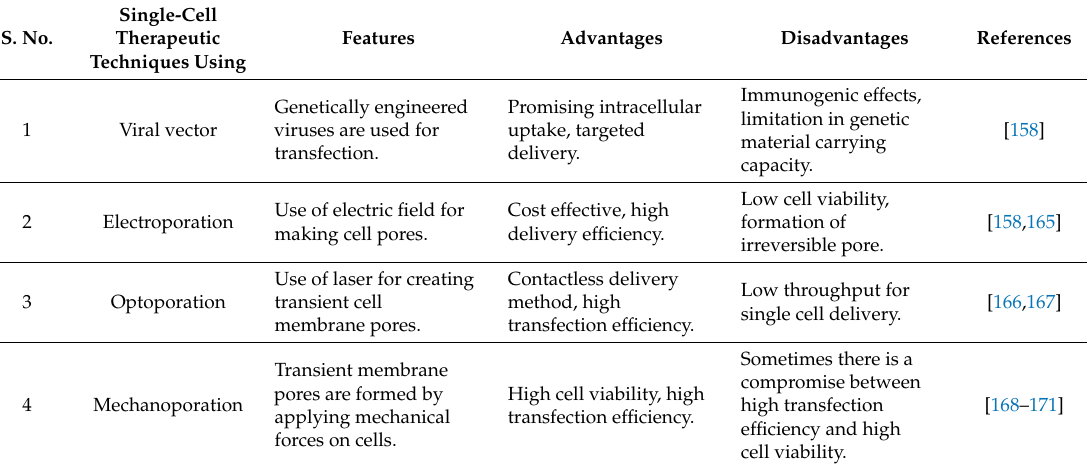
Table 3. Single-Cell therapeutic